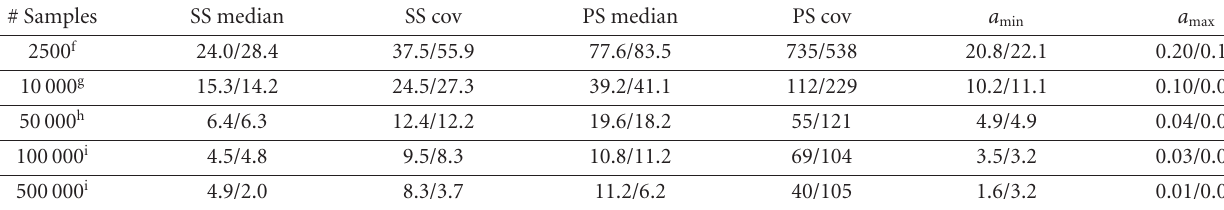
Table 4: Comparison of coe ffi cient of variation, in percent, as a function of number of samples per zone. # Samples